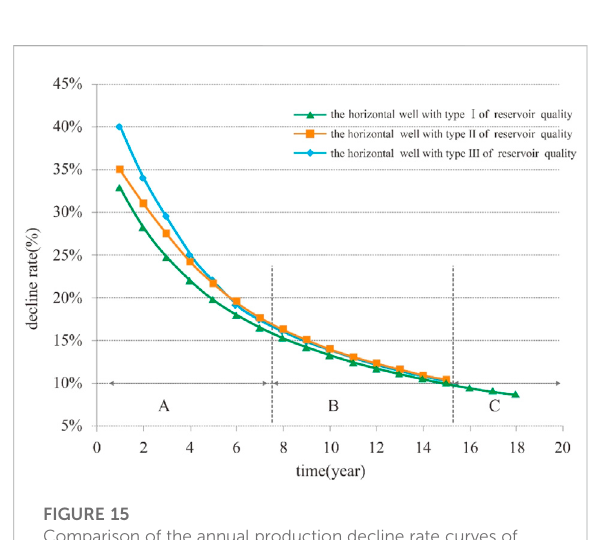
FIGURE 15 Comparison of the annual production decline rate curves of the horizontal wells with three types of reservoir